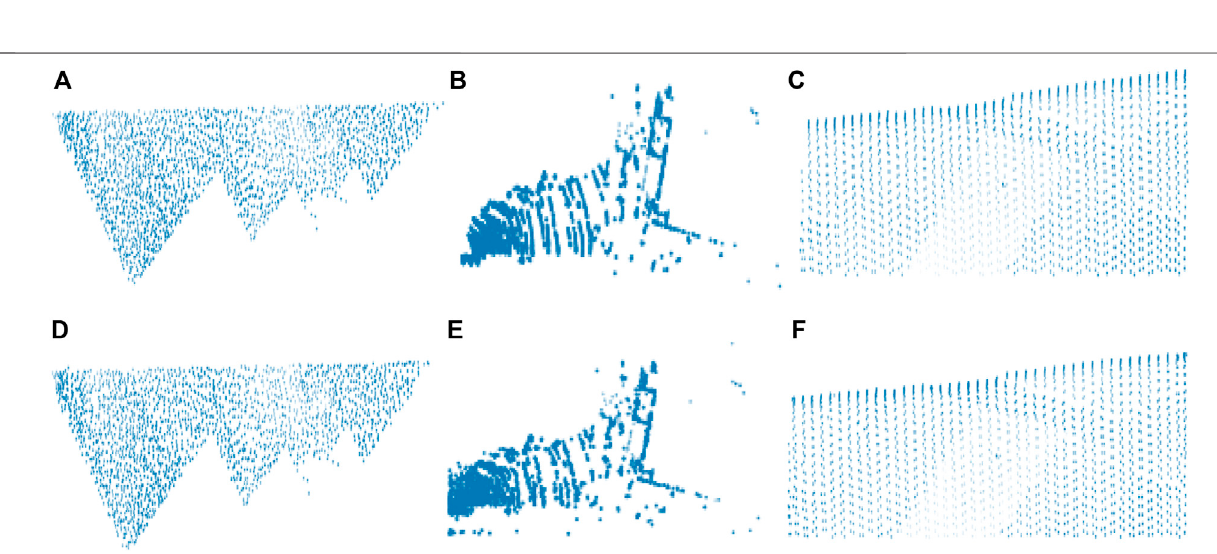
TABLE 2 | The performance comparison between the different combinations of loss and optimizer functions on two sample images from each dataset. Point Optimization Function Search Space Loss Function Search Cloud Test Images